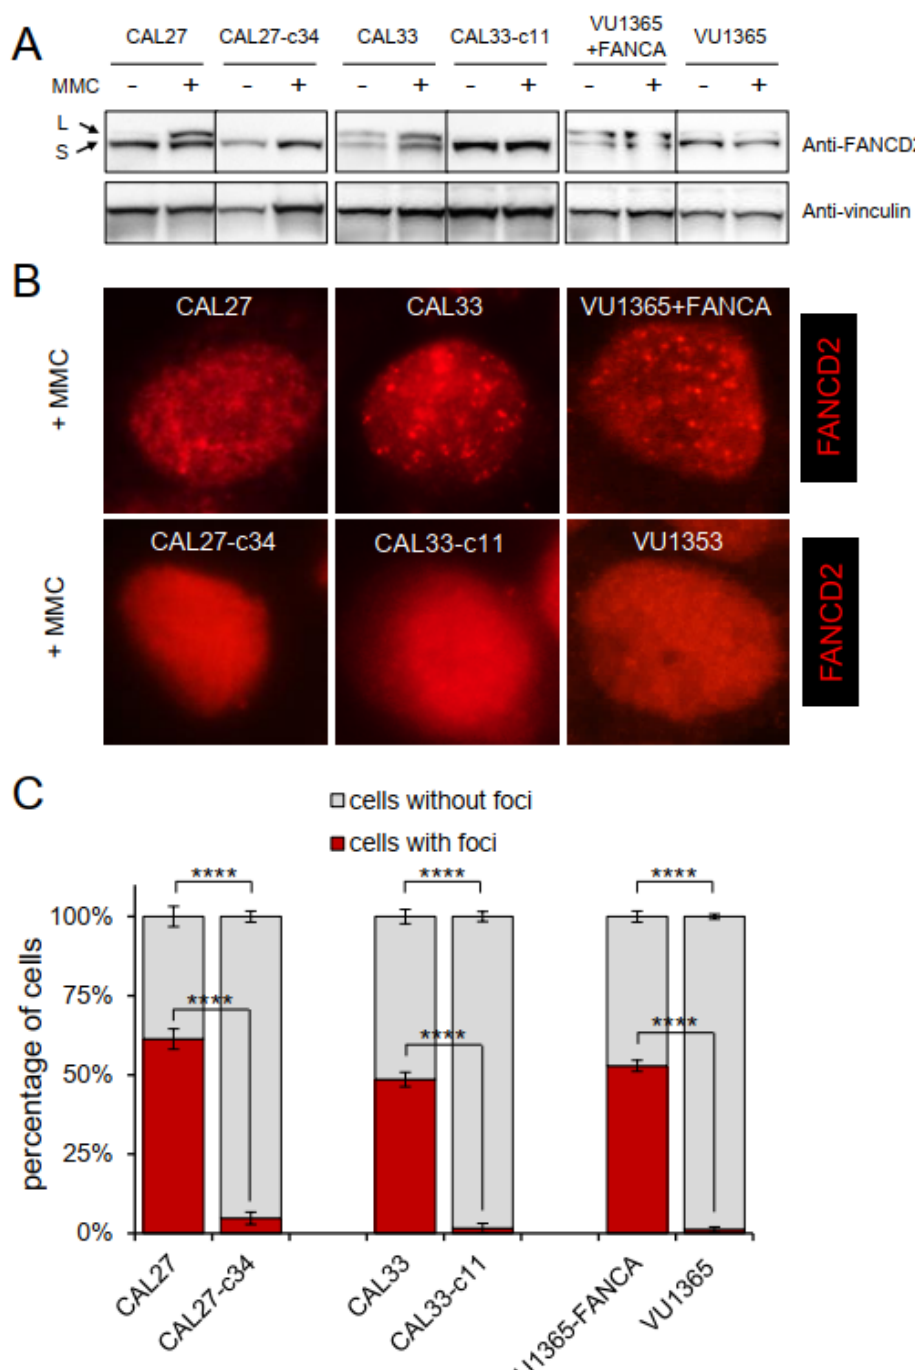
Figure 3. FANCA -edited HNSCC cells are defective in FANCD2 monoubiquitination and nuclear foci formation. CAL27, CAL33, and VU1365 parental and derivative cells were treated with IC50 concentration of MMC for 1 h and harvested. ( A ) Western blot with anti-FANCD2 antibody showing that FANCD2 monoubiquitination was not observed in FANCA mutant CAL27 and CAL33 clones (CAL27-c34 and CAL33-c11, respectively) suggesting a defective Fanconi pathway. As reported, parental VU1365 also lacked FANCD2 ubiquitination, which was corrected upon FANCA complementation (VU1365-FANCA). A vinculin antibody was used as housekeeping control. ( B ) Immunofluorescence analysis with FANCD2 antibody. FANCA -mutant cells (CAL27-c34, CAL33-c11) cannot form nuclear foci after 1 h of MMC treatment at IC50 concentration. ( C ) Quantification of nuclear foci in treated and untreated cells. Data represent mean ± SEM. p -values were calculated using a two-way ANOVA test, ****: p -value ≤ 0.0001.